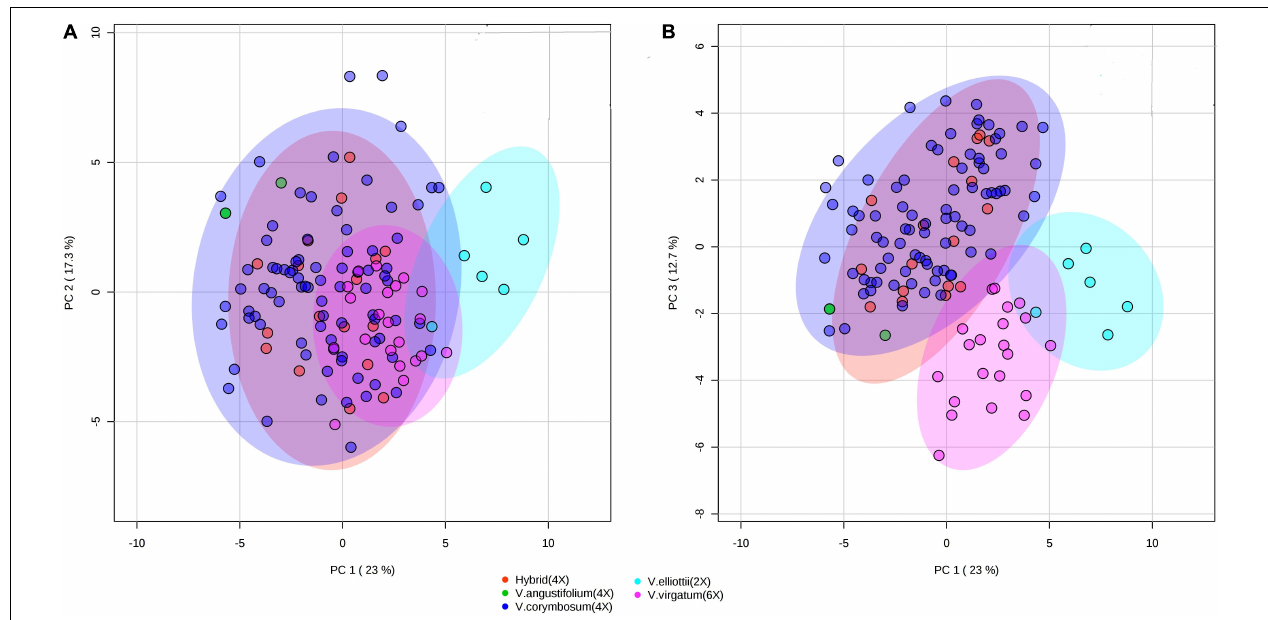
FIGURE 8 | PCA score plots of the first and second (A) and first and third (B) principal components. The data obtained from metabolites and fruit quality data of 128 blueberry accessions from five species (hybrid, V. elliottii , V. virgatum , V. angustifolium , and V. corymbosum ).